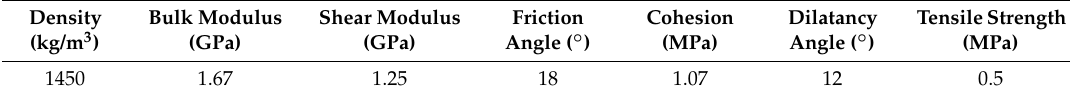
Table 2. The mechanical parameters of the coal